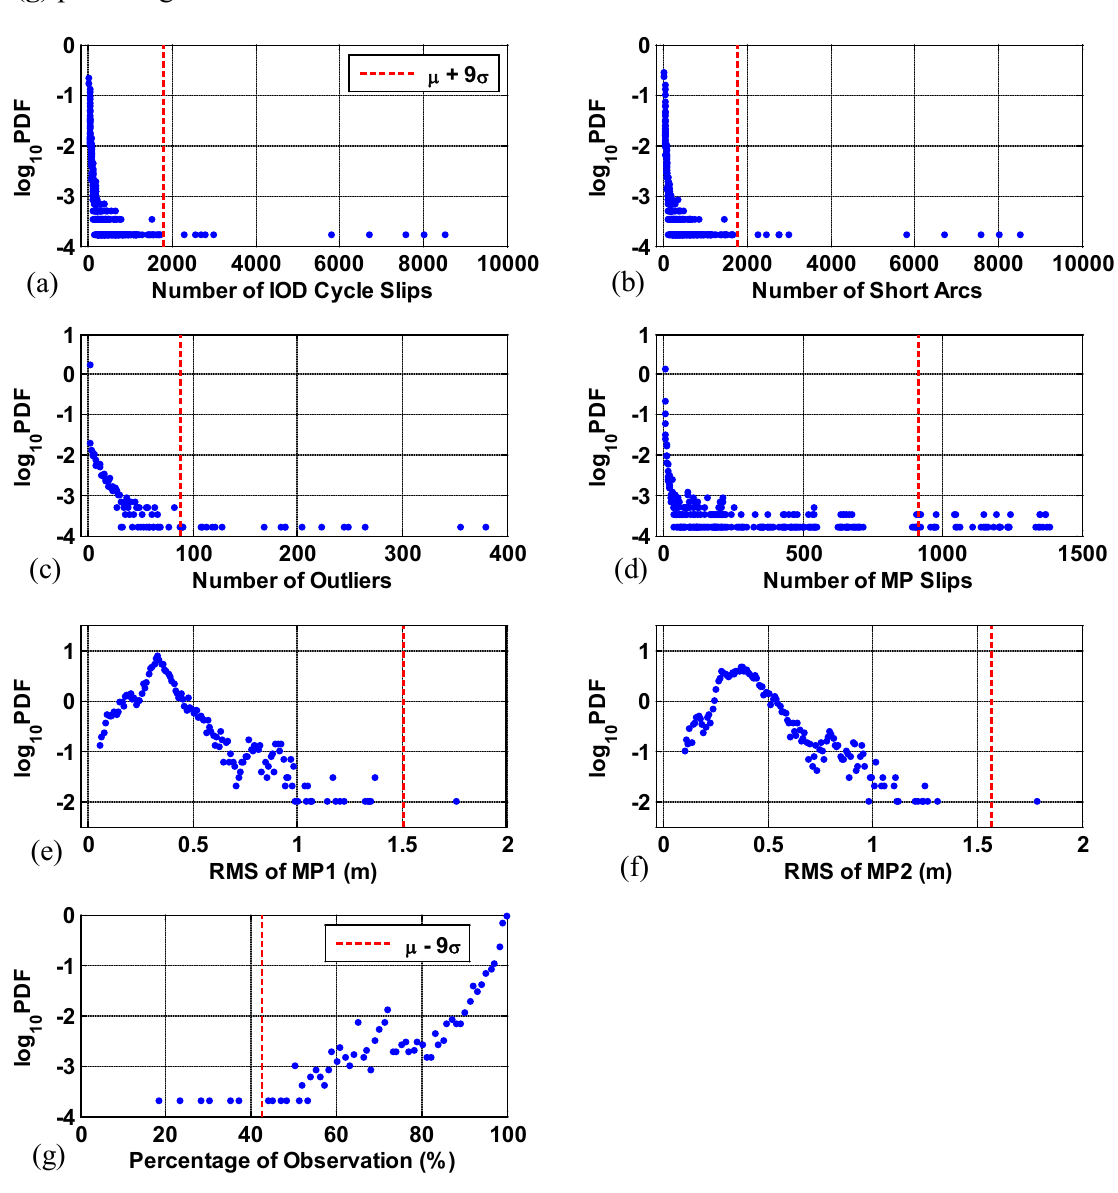
Figure 9. Probability density function of data quality parameter for each station per day (data collected for seven days): ( a ) number of IOD cycle slips; ( b ) number of short arcs; ( c ) number of outliers; ( d ) number of MP slips; ( e ) RMS of MP1; ( f ) RMS of MP2; and ( g ) percentage of